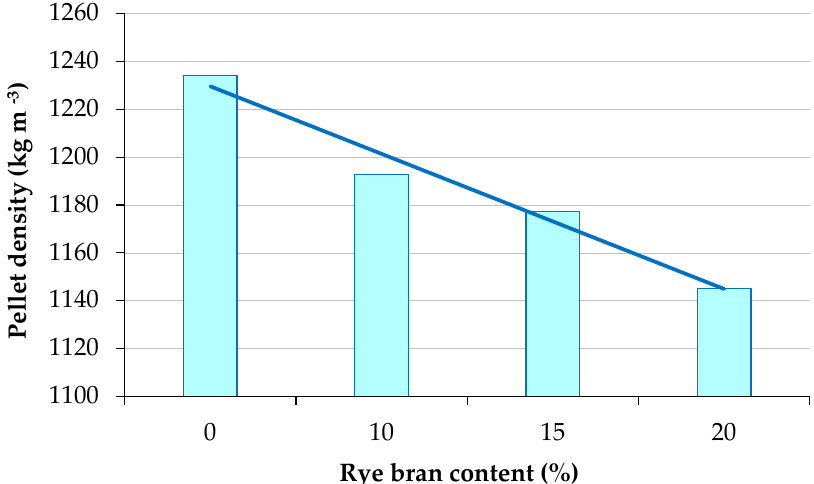
Figure 4. Physical density of sage straw pellets with different rye bran content.